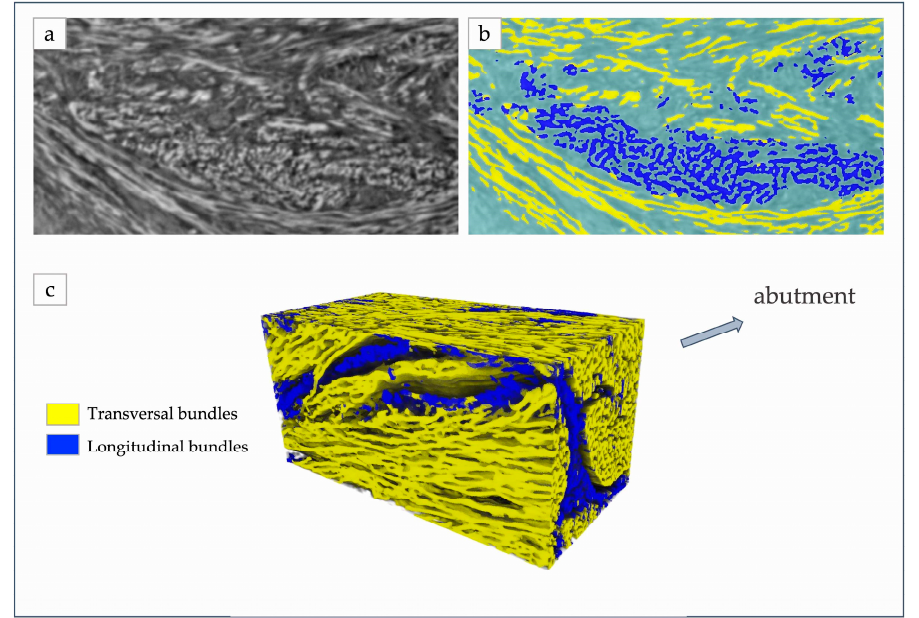
Figure 3. Thresholding ( a , c , e ) vs. semantic ( b , d , f ) segmentation methods. Examples of comparisons on homologous slices: ( a , b ) Ctr1_st_wt; ( c , d ) Ctr2_lt_no-wt; ( e , f ) Pt2_st_no-wt_l.